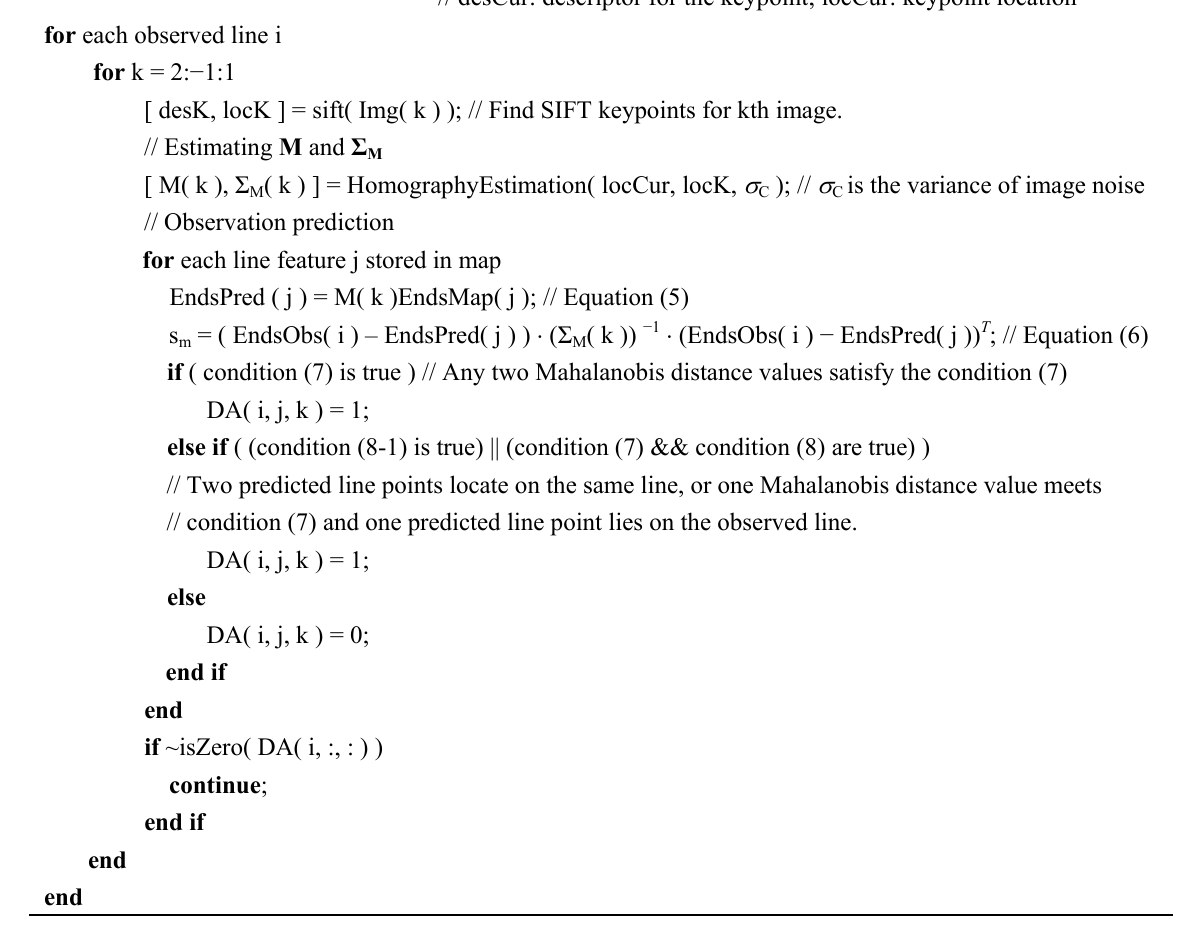
Algorithm 1. HTMDA